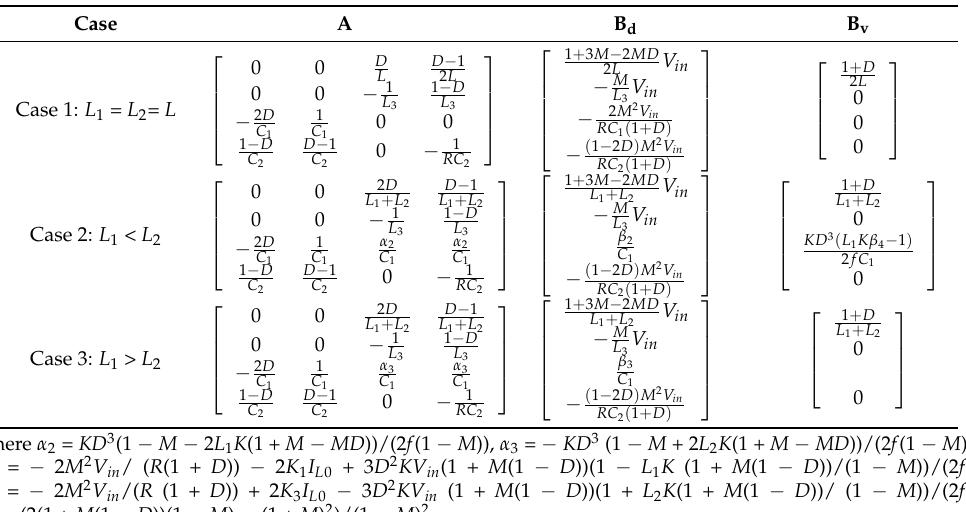
Table 4. Expressions for A , B d and B v for the proposed step-up converter.